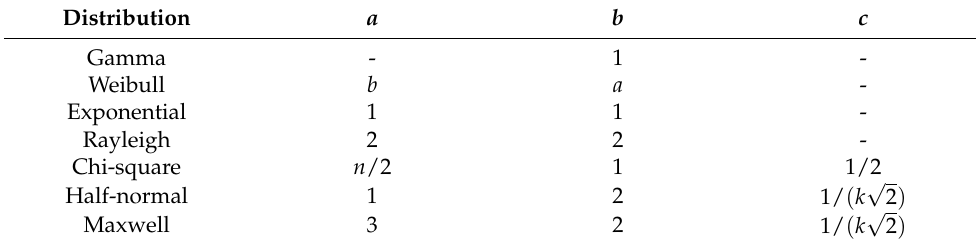
Table 1. Stacy special